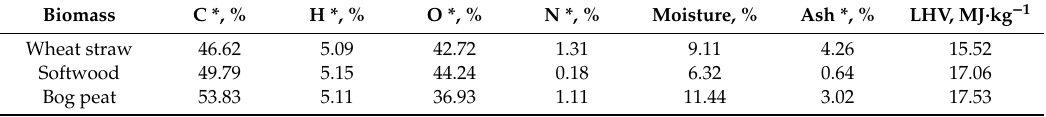
Table 1. The elemental composition and heating values of straw, wood and peat pellets. Biomass C *,